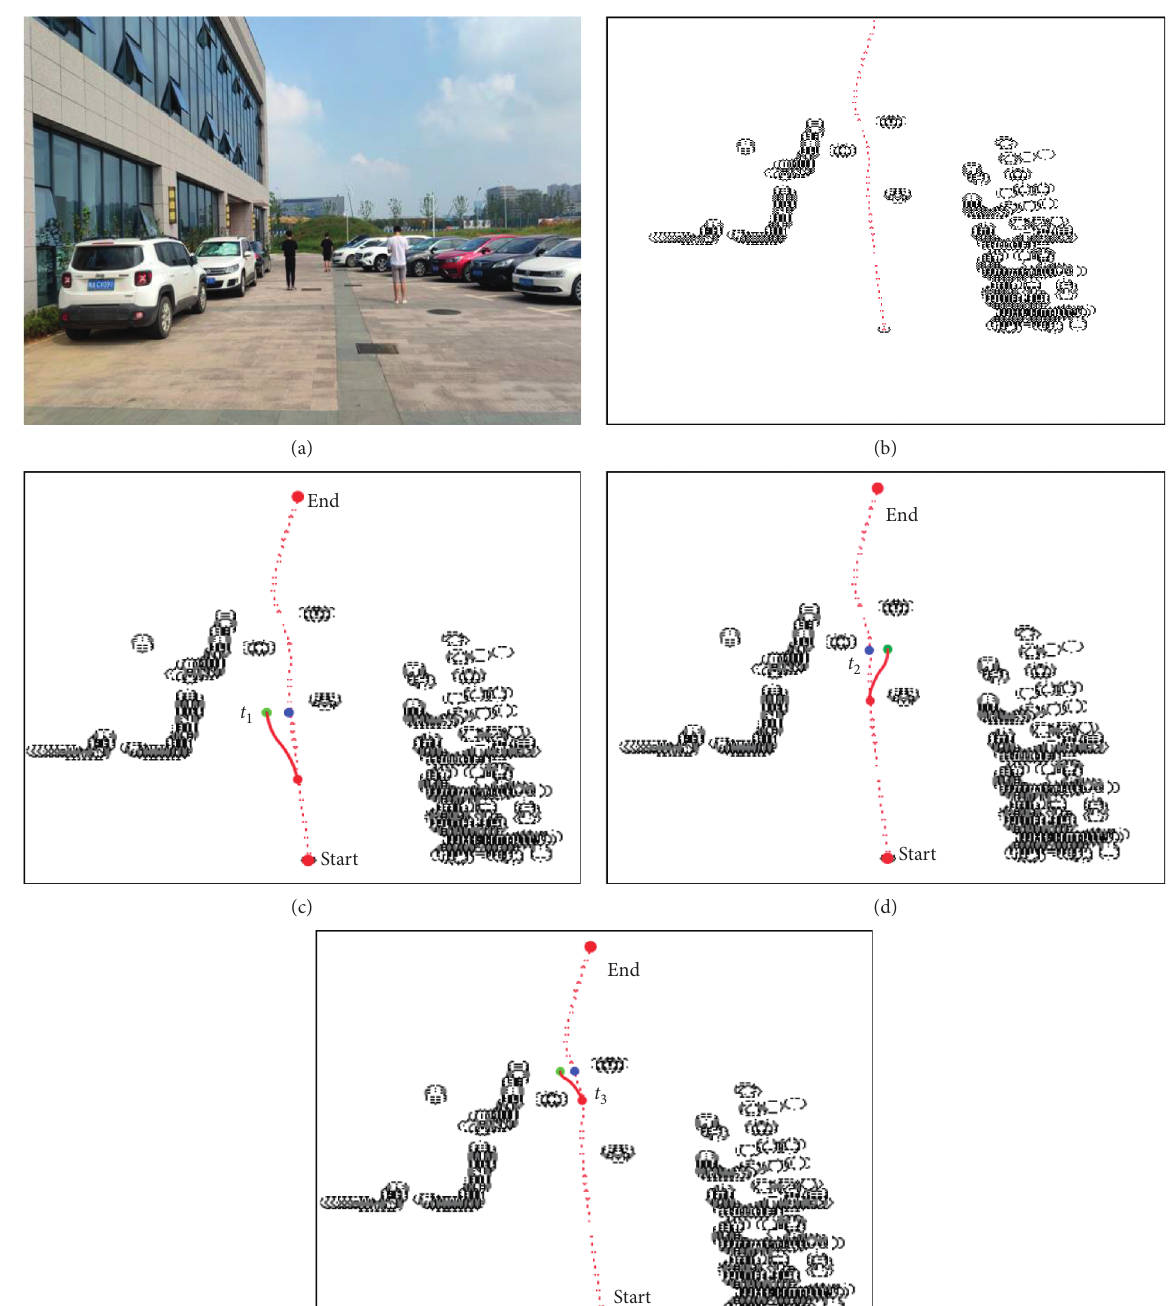
Figure 24: The results of two-layered path planning method in scenario 3. (a) The experiment scenario. (b) The improved Bi-RRTplanning result in high-level model. (c) The planning result of low-level model at time t 1 . (d) The planning result of low-level model at time t 2 . (e) The planning result of low-level model at time t 3